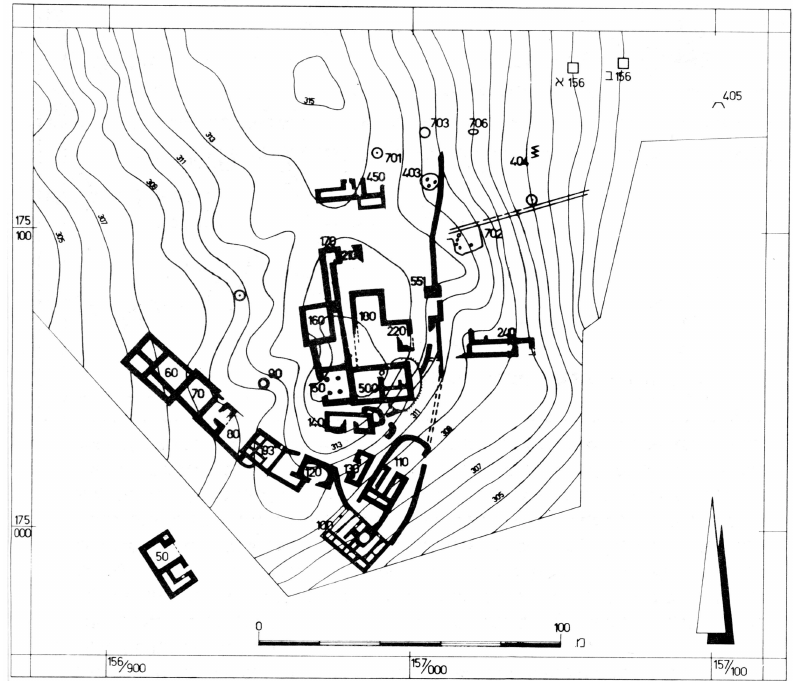
Figure 4. A plan of Kh. Jemein. Most of this Iron Age village was excavated, but no temple was unearthed (courtesy of Shimon